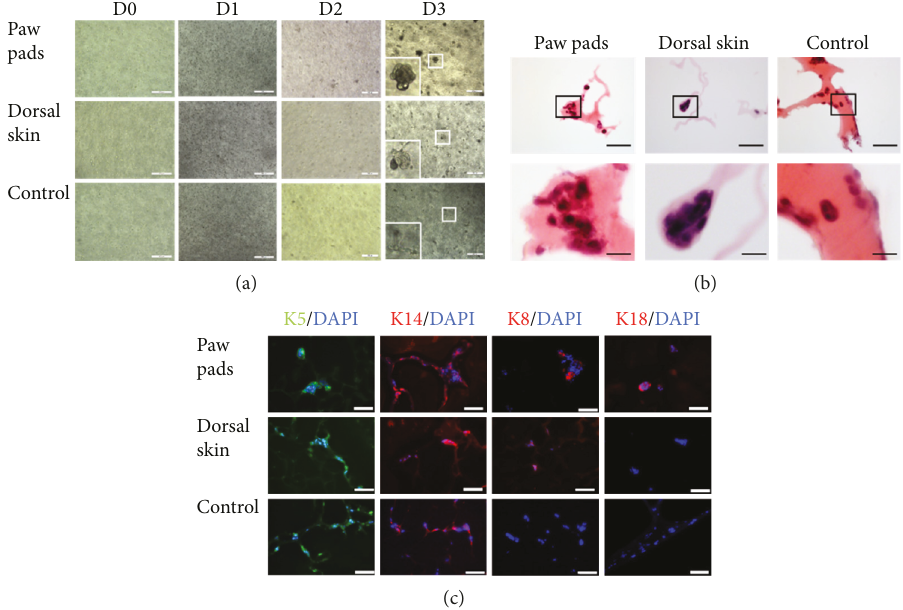
Figure 3: Epidermal stem cells developed into glandular cell clusters by coculture with EPP tissue. Epidermal stem cells were induced into glandular cell clusters by coculture with EPP tissue. Nonglandular or “ sea snail ” cell clusters were formed in the group with embryonic dorsal skin. (a) Morphological alterations of epidermal stem cells in di ff erent inducing development systems were observed by inverted microscope (all bars = 200 μ m). (b) Histological features of multicellular clusters were evaluated by H&E staining in di ff erent inducing development systems ( bars = 200 μ m and 50 μ m). (c) Speci fi c biomarkers of sweat gland development were detected by immuno fl uorescent staining in di ff erent inducing development systems. All the nuclei were counterstained with DAPI (DAPI: blue; K5: green; and K14, K8, and K18: red) ( bars = 50 μ m). (K5: cytokeratin 5, K14: cytokeratin 14, K8: cytokeratin 8, and K18: cytokeratin